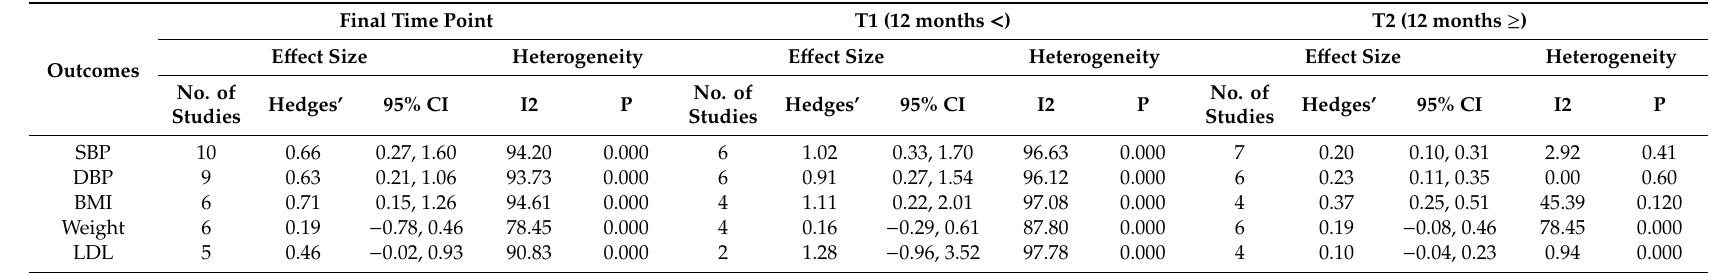
Table 2. E ff ect size at the final point, at each point for